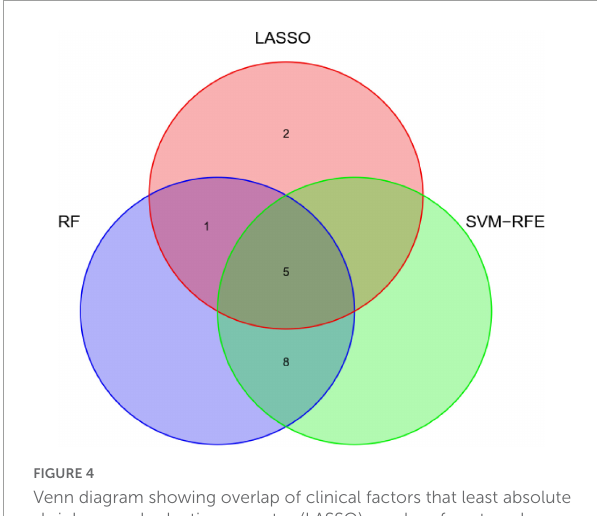
FIGURE4 Venn diagram showing overlap of clinical factors that least absolute shrinkage and selection operator (LASSO), random forest, and support vector machine-recursive feature elimination (SVM-RFE) methods identified as predictors of disseminated intravascular coagulation (DIC) in heatstroke patients.